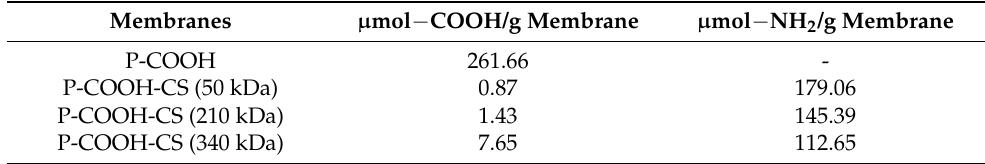
Table 1. Carboxyl and amine contents of nanofiber membranes.